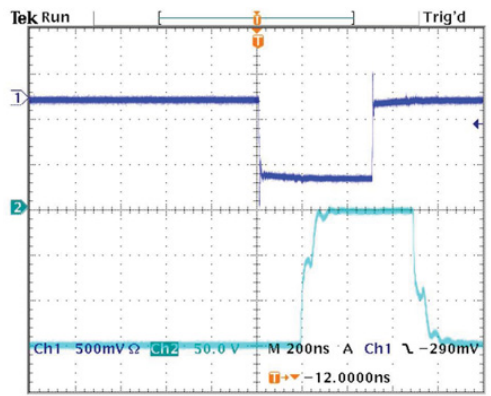
Figure 6. Signals measured using an oscilloscope. Blue: BN gate trigger NIM signal. Turquoise: − 150V BN gate pulse.